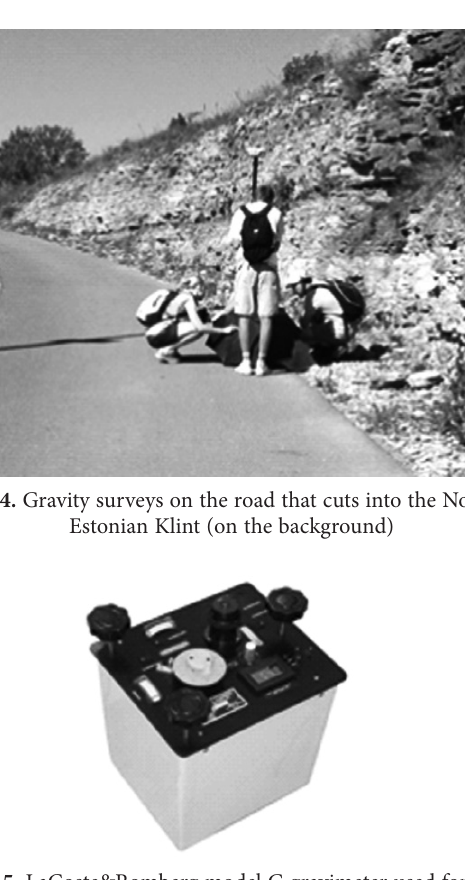
Fig. 5. LaCoste&Romberg model G gravimeter used for the collection of gravity